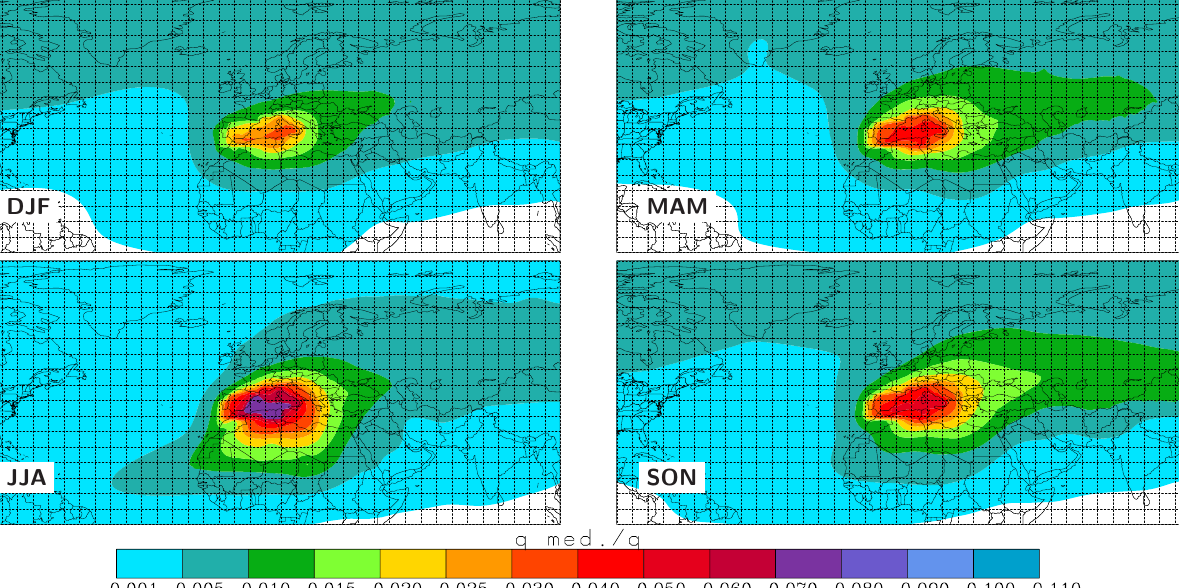
Fig. 8. Same as Fig. 7 (moisture ratio) but for the western Mediterranean